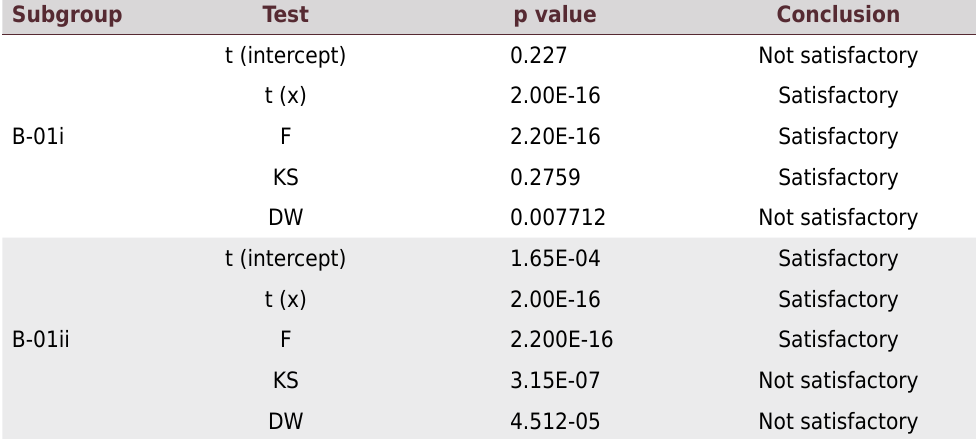
Table 3. Summary of the results of the statistical tests for the correlations evaluated in B-01 Subgroup Test